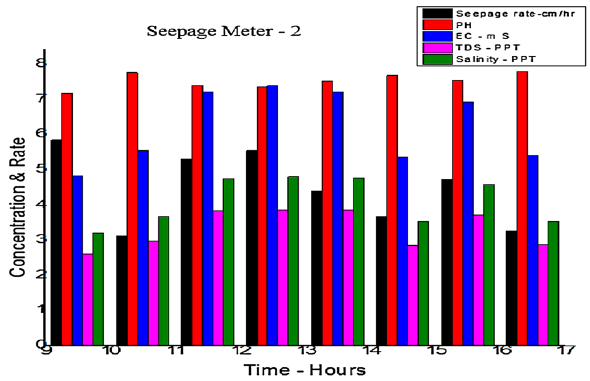
Fig. 6 Comparison of seepage rate and physicochemical parameters for the seepage meter 2